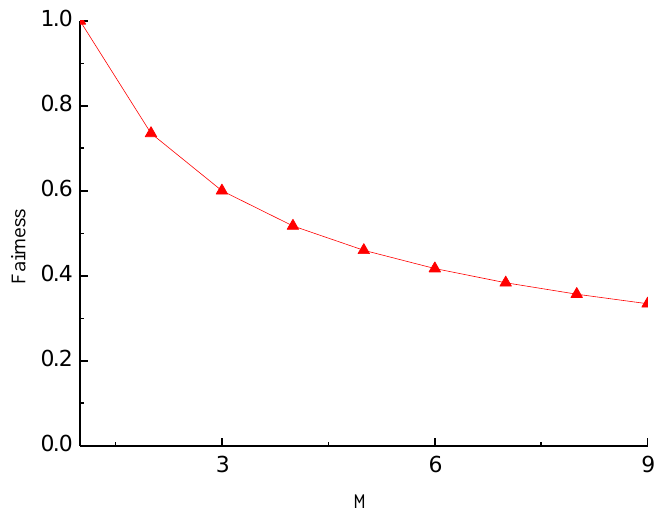
Figure 5. Fairness of sensor nodes in each circle transmitting data with different network